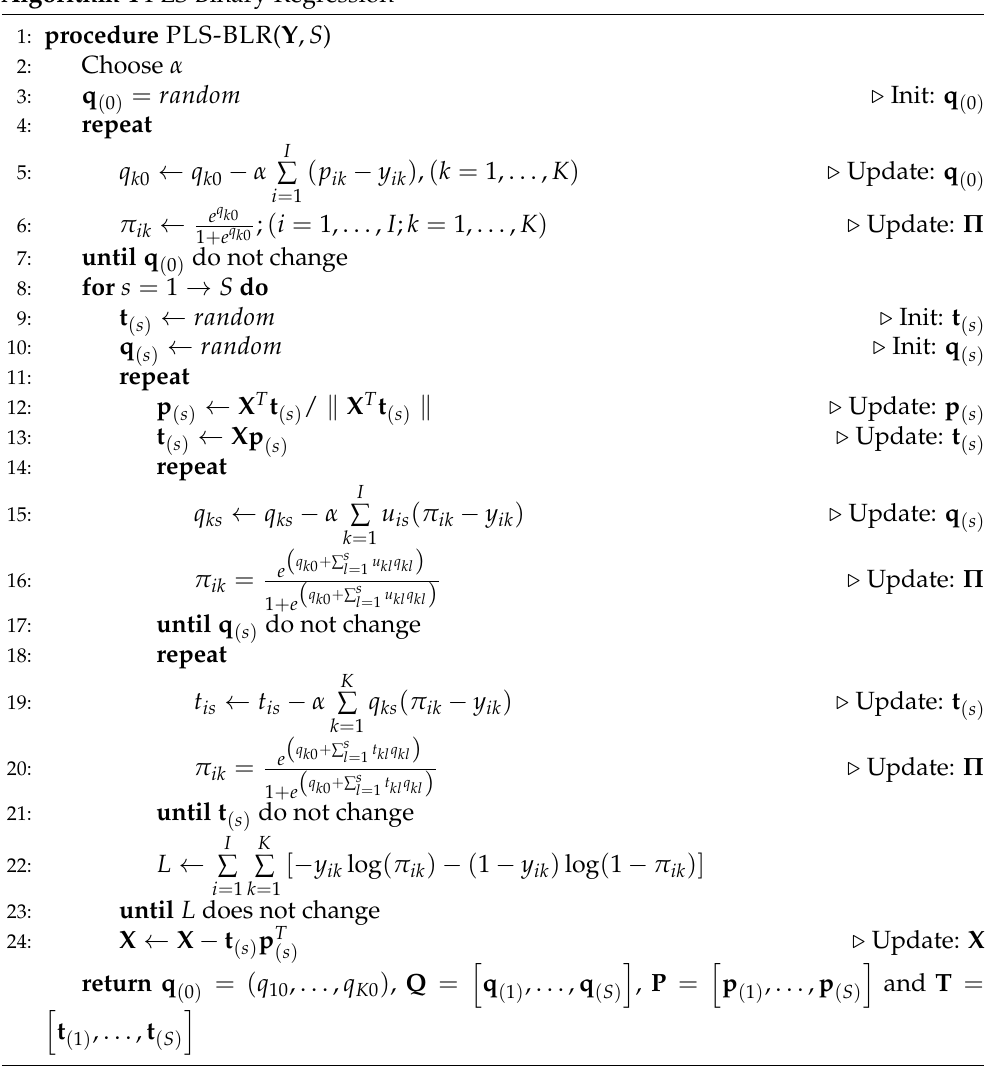
Algorithm 4 PLS Binary